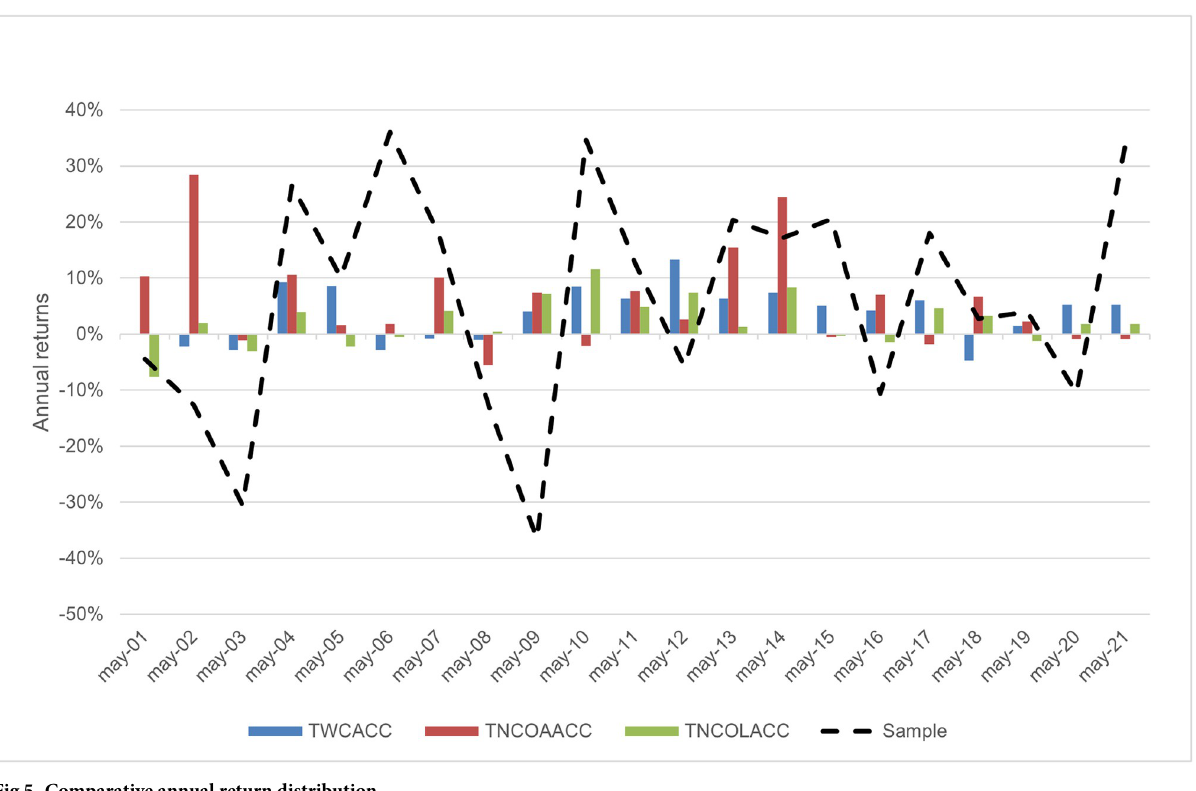
Fig 5. Comparative annual return